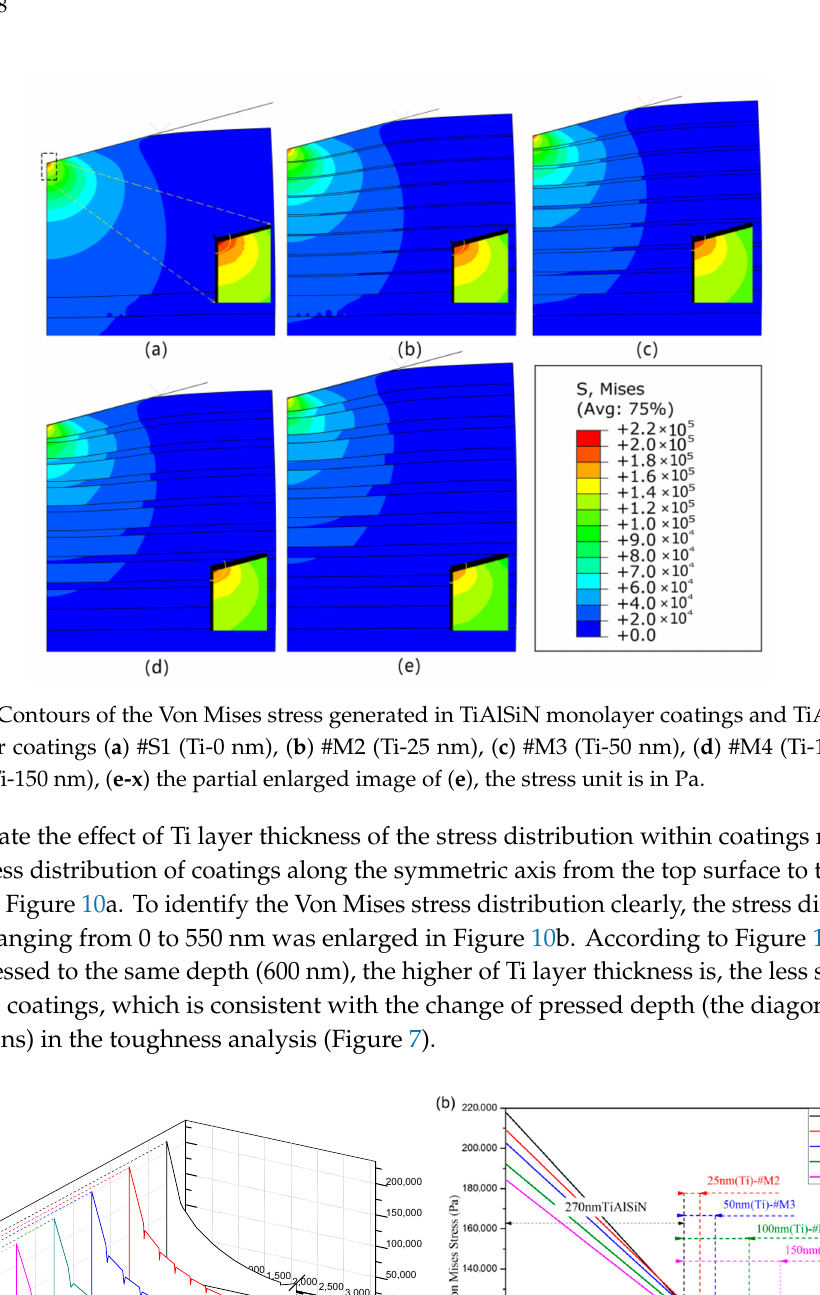
Figure 9. Contours of the Von Mises stress generated in TiAlSiN monolayer coatings and TiAlSiN/Ti multilayer coatings ( a ) #S1 (Ti-0 nm), ( b ) #M2 (Ti-25 nm), ( c ) #M3 (Ti-50 nm), ( d ) #M4 (Ti-100 nm), ( e ) #M5 (Ti-150 nm), ( e-x ) the partial enlarged image of ( e ), the stress unit is in Pa.